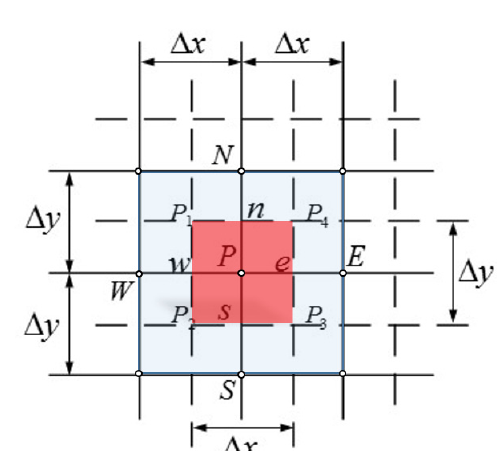
Figure 3. Control volume for a grid point P on the non-staggered grids. The dash lines in the figure divide the calculation region into sub-regions, and each sub-region is a control volume. For example, the control volume for the grid point P is the red region. The intersection points of the solid lines determine the center points of the control volumes, which are the grid nodes.